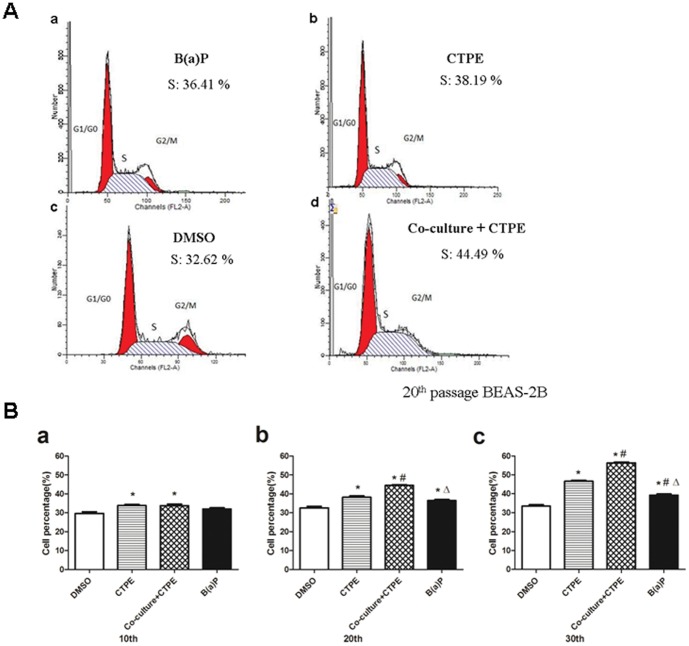
Cell growth rate assays of BEAS-2B cells at passage 10, 20 and 30 in four groups.BEAS-2B cells were treated with 2.4 µg/mL CTPE for 72 hours. After removal of CTPE, the BEAS-2B cells were cultured in the presence or absence of THP-1 cells and passaged. The percentage of S-phase BEAS-2B cells at passage 10, 20 and 30 was determined using flow cytometry. (A) Representatives of DNA content of BEAS-2B cells at passage 20 in four groups. (B) The percentage of BEAS-2B cell in S phase among different passages and groups. The percentage of the S phase cells in Co-culture/CTPE group started to increase at passage 10; was higher than that of CTPE or B(a)P at passage 20, and kept the highest level at passage 30.(n = 6, *: vs DMSO, P<0.05; #: vs CTPE, P<0.05; Δ:vs Co-culture+CTPE, P<0.05). Phenotypes were triplicated.